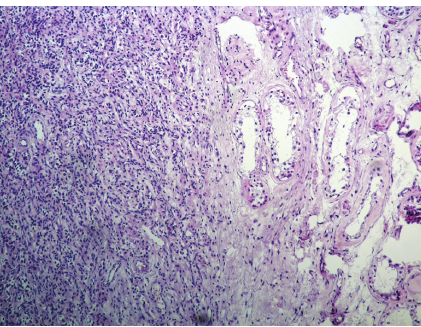
Figure 2: Granulosa tumor of the testis with trabecular and diffuse solid pattern is seen on the left part of the picture, while atrophic testicular parenchyma is seen on the right part of the picture (H&E × 100).